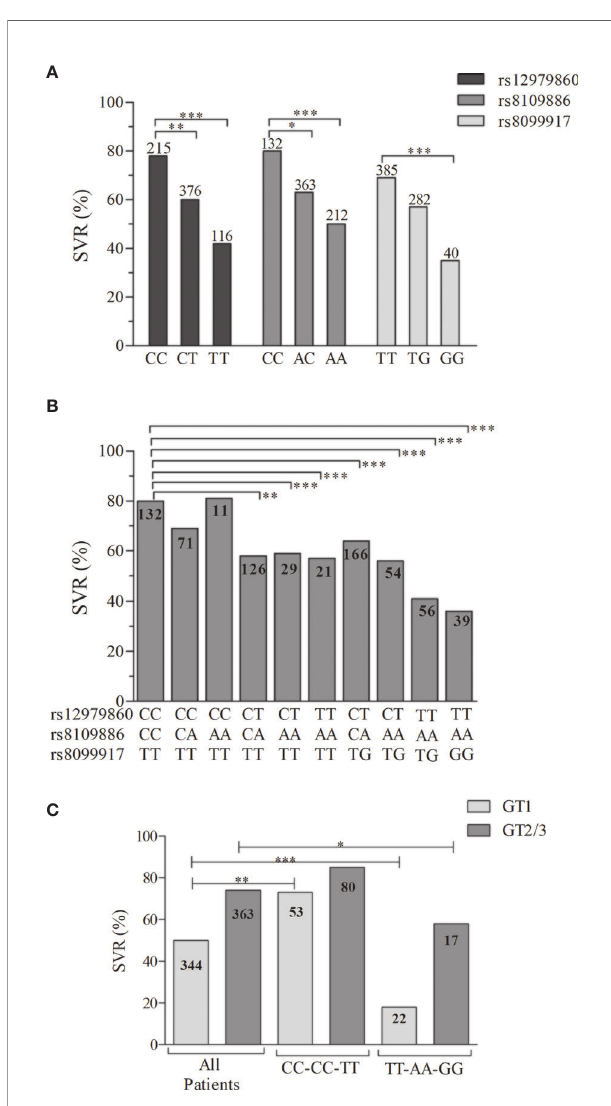
FIGURE 2 | Distribution of the SVR rates from the patients with CHC treated with Peg-IFN a . The distribution is strati fi ed by (A) the genotypes of the SNPs rs12979860, rs8109886, and rs8099917, (B) the genotypic combination of those SNPs, and (C) the genotypic combination of the opposite prognostic markers. The column numbers represent the available individuals in each group. The SVR percentage were compared among groups by the Fisher ’ s exact test (*P < 0.05, **P < 0.001, ***P <